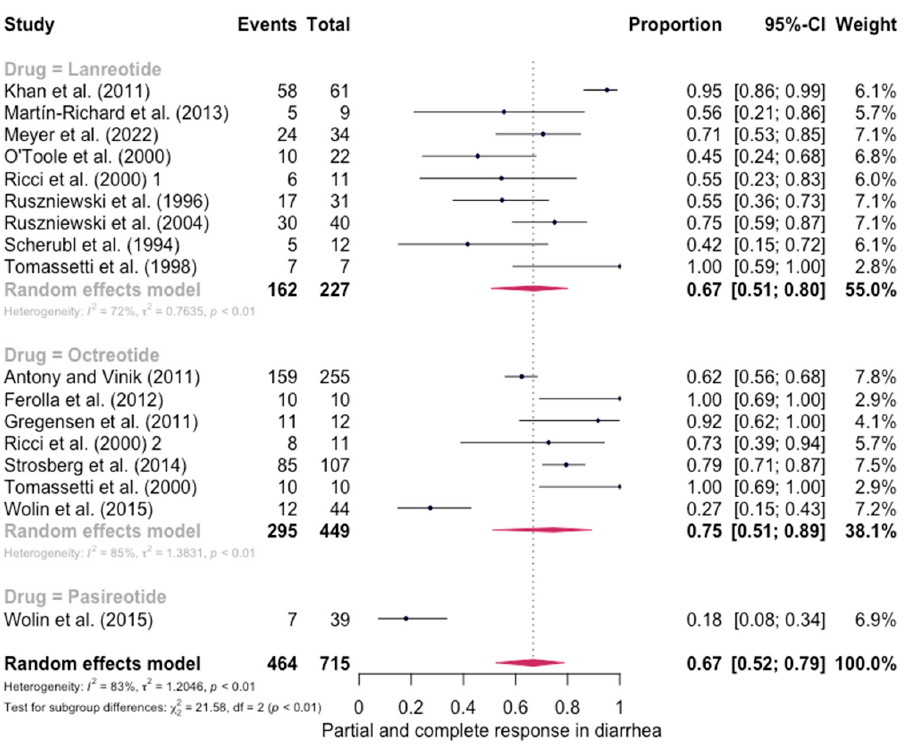
Figure 2. Forest plot showing the pooled PR and CR for diarrhea in patients with carcinoid syndrome. CI: confidence interval. p refers to Cochran’s Q test for heterogeneity [21,22,34,48–60] .